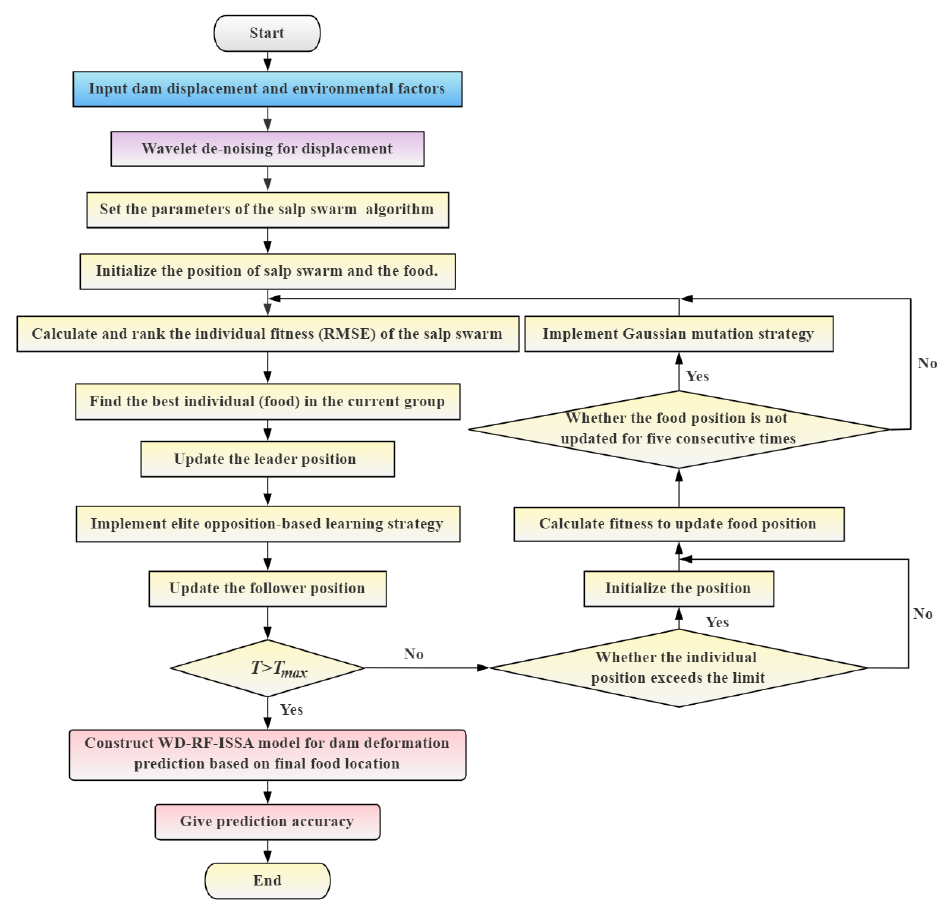
Figure 4. Construction process of the proposed dam deformation prediction model .